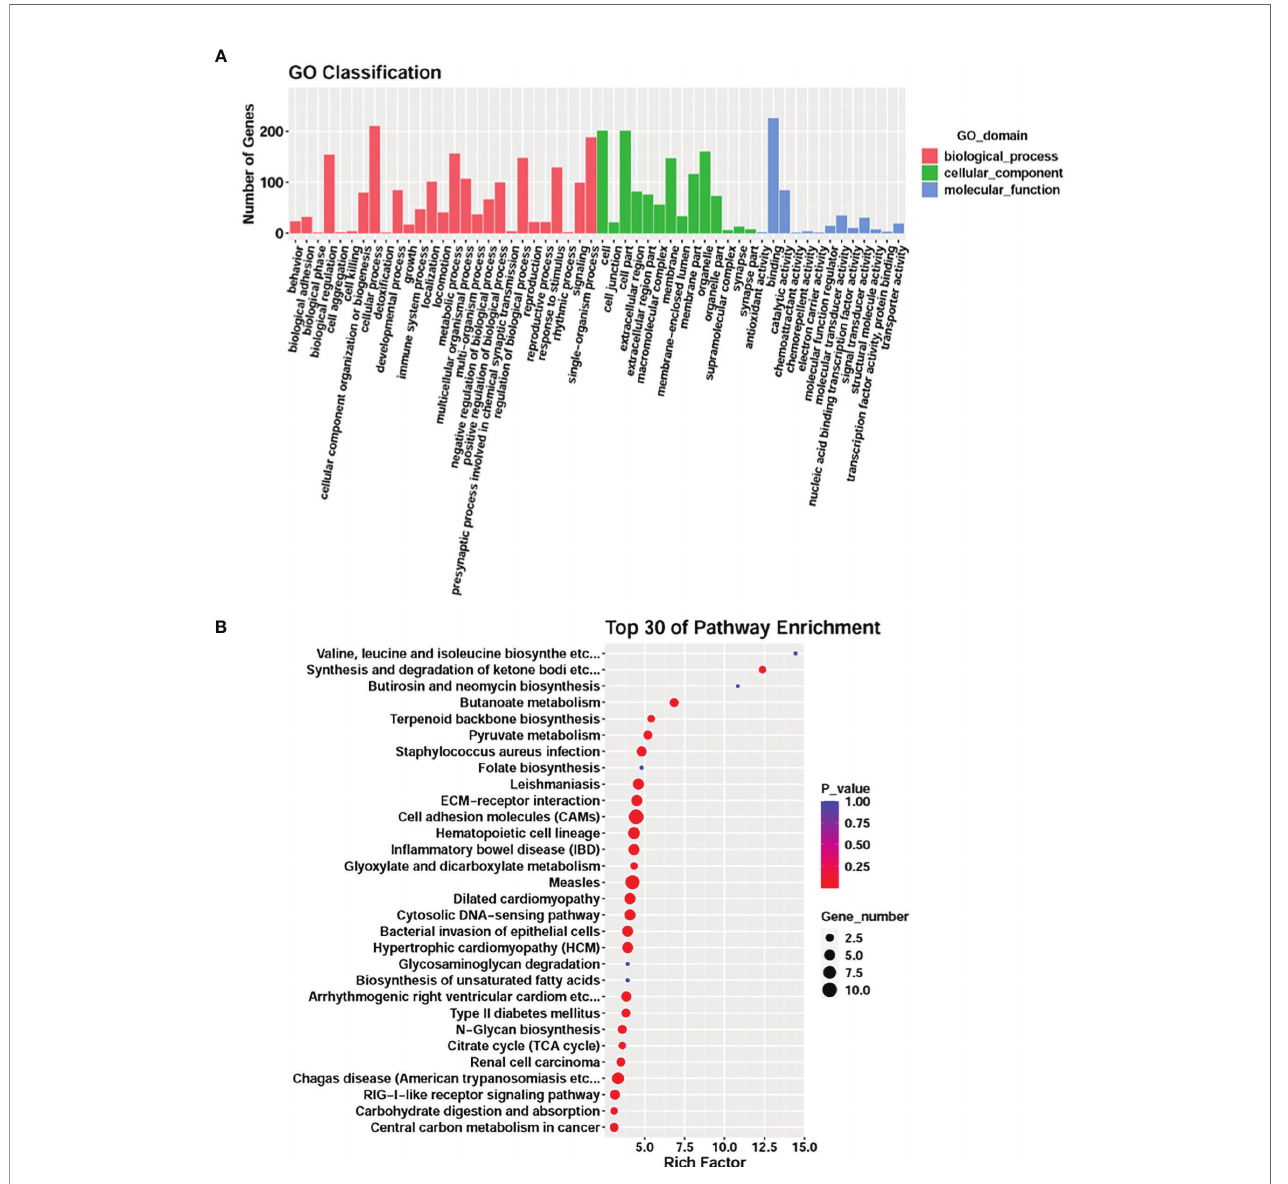
FIGURE 5 | GO functional category analysis and KEGG pathway enrichment of the inversely correlated genes in G. parasuis -infected porcine brain. (A) GO functional category analysis of inversely correlated genes. The vertical axis shows the number of genes in each term, and the horizontal axis shows biological processes, cellular component, and molecular function terms. (B) KEGG pathway enrichment of inversely correlated genes. Top 30 KEGG pathways are shown in the vertical axis and the horizontal axis shows the rich